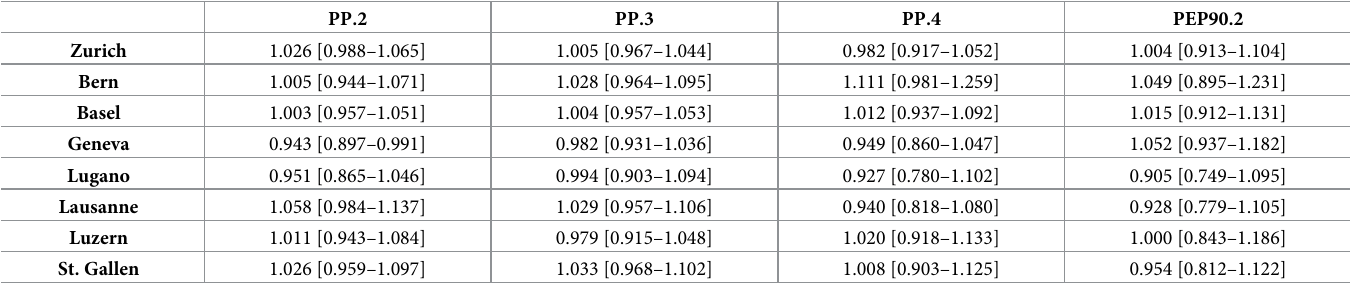
Table 4. Pooled association estimates of city-specific analysis between hospital admissions due to mental disorders and PP.2 PP.3, PP.4, and PEP90.2 events with lag 3 (Relative Risk [95% confidence